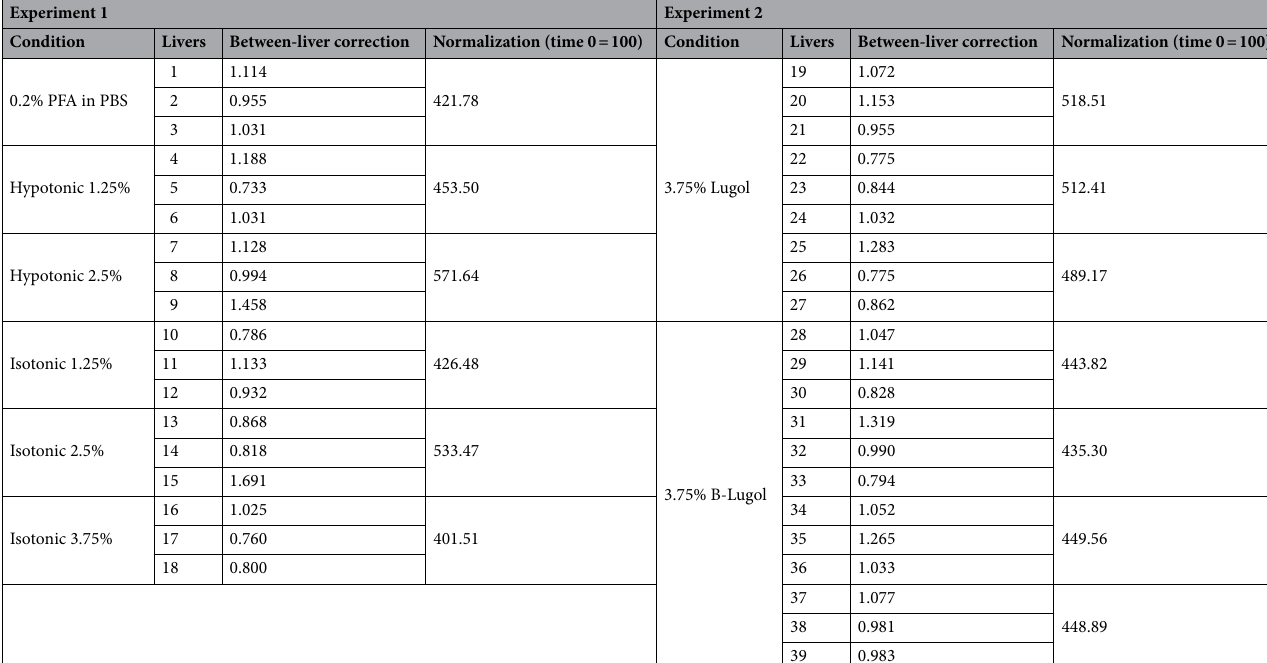
Table 1. Between-liver correction and normalization. To remove random differences between livers, without losing the effects of Condition and Time, a correction factor (column Between-liver correction) was determined 15 and applied to the data measured for each liver. Thereafter, the volume data were normalized by dividing each value by the average volume per condition at time 0 (column normalization factor) and multiplied by 100; effectively scaling the average volume at time 0 to